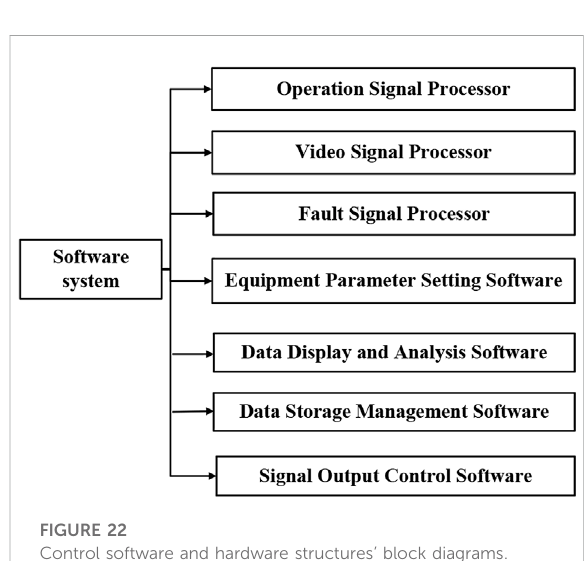
FIGURE 22 Control software and hardware structures ’ block